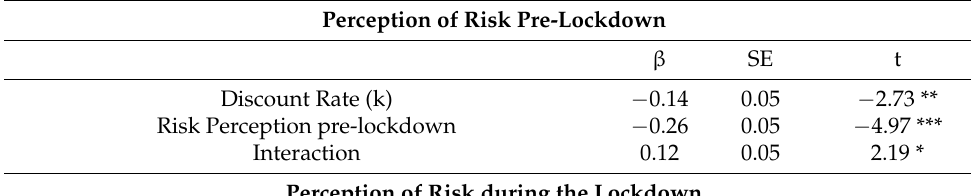
Table 4. Overview of the results of the moderation